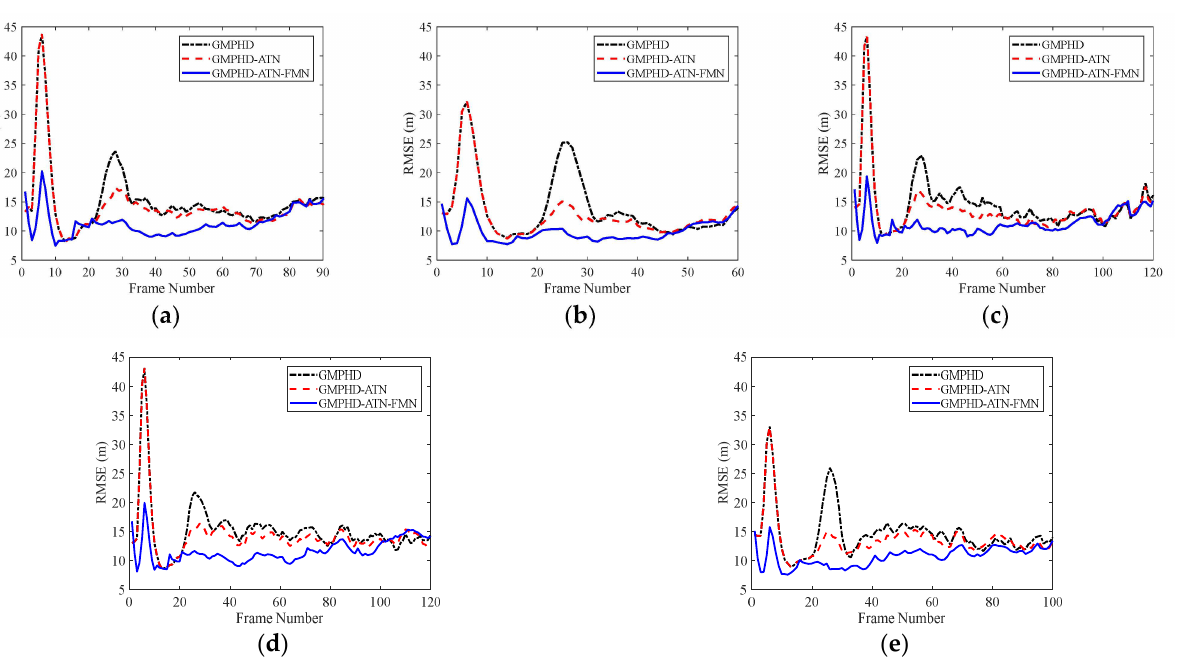
Table 8. Target trajectory parameters.